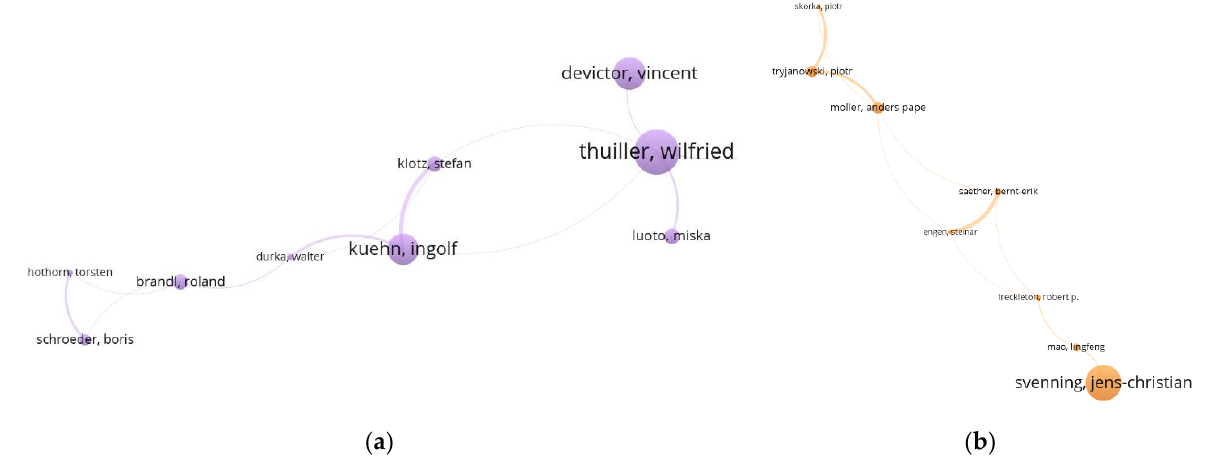
Figure 6. Two research communities in Europe: ( a ) Thuiller – Kuehn community (Thuiller, 24.31; Kuehn, 16.73); and ( b ) Svenning community (Svenning, 26.21). (Note: Figure 6b is zoomed out to fit the typesetting. In fact, the node of Svenning is slightly bigger than the node of Thuiller in ( a )).